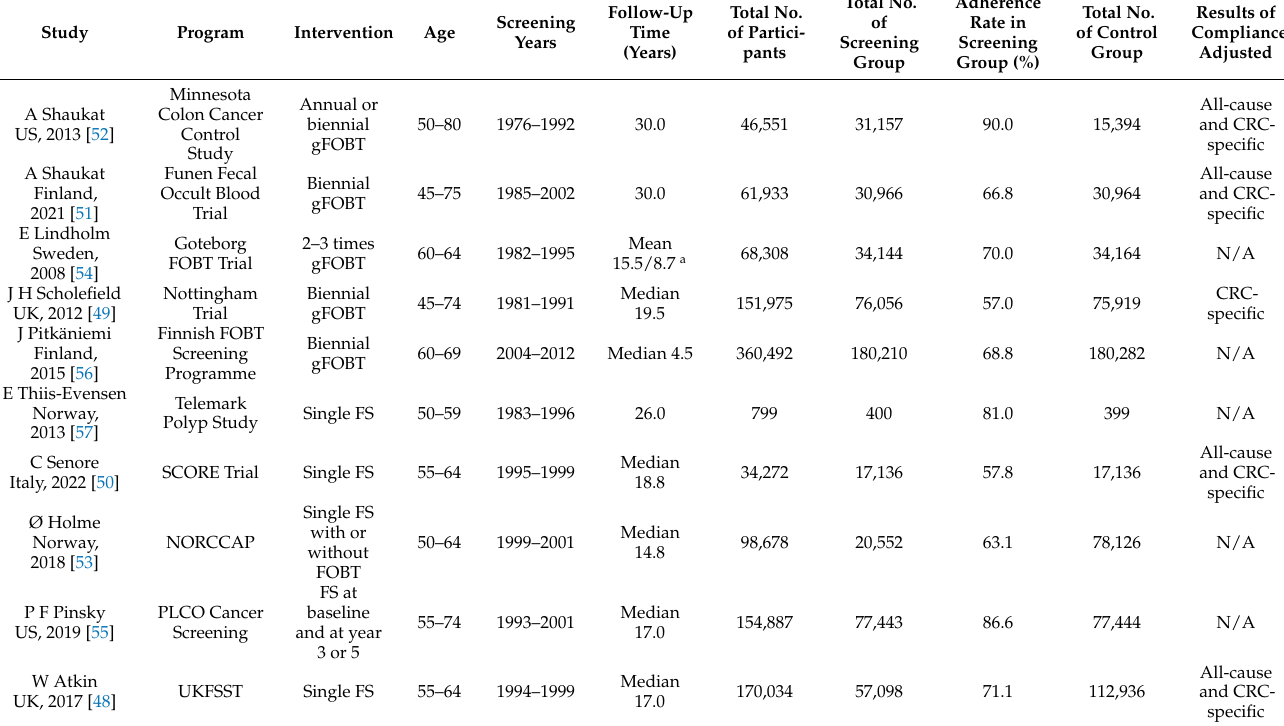
Table 1. Characteristics of randomized controlled